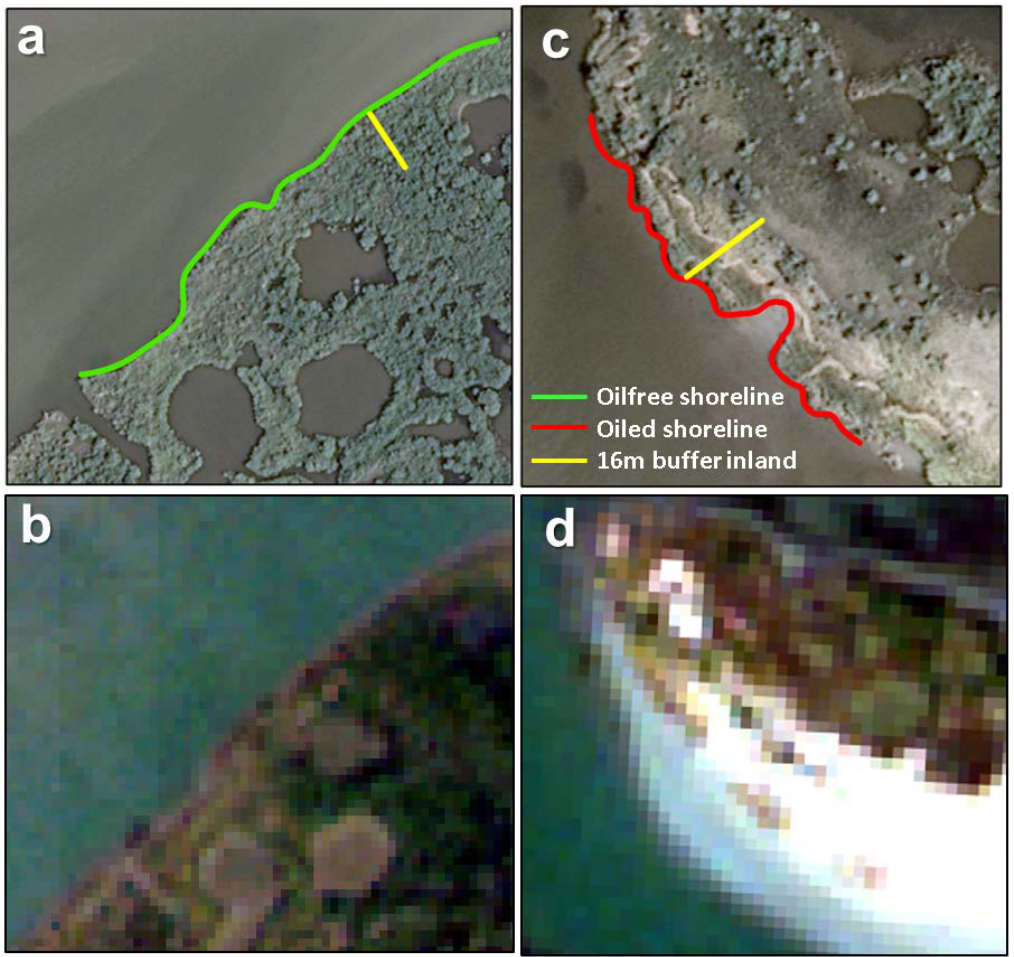
Figure 6. ( a ) SCAT shoreline data overlaid on 2010 GIS Aerometric 0.3 m imagery of a section of Chandeleur Islands with a yellow line marking the extent of the 16 meter buffer used in the analyses, ( b ) AVIRIS true color image showing the same extent of ( a ) at 7.7 m resolution, ( c ) SCAT shoreline data overlaid on 0.3m imagery of a section of Chandeleur Islands, ( d ) AVIRIS true color image showing the extent of ( c ) at 7.7 m resolution.